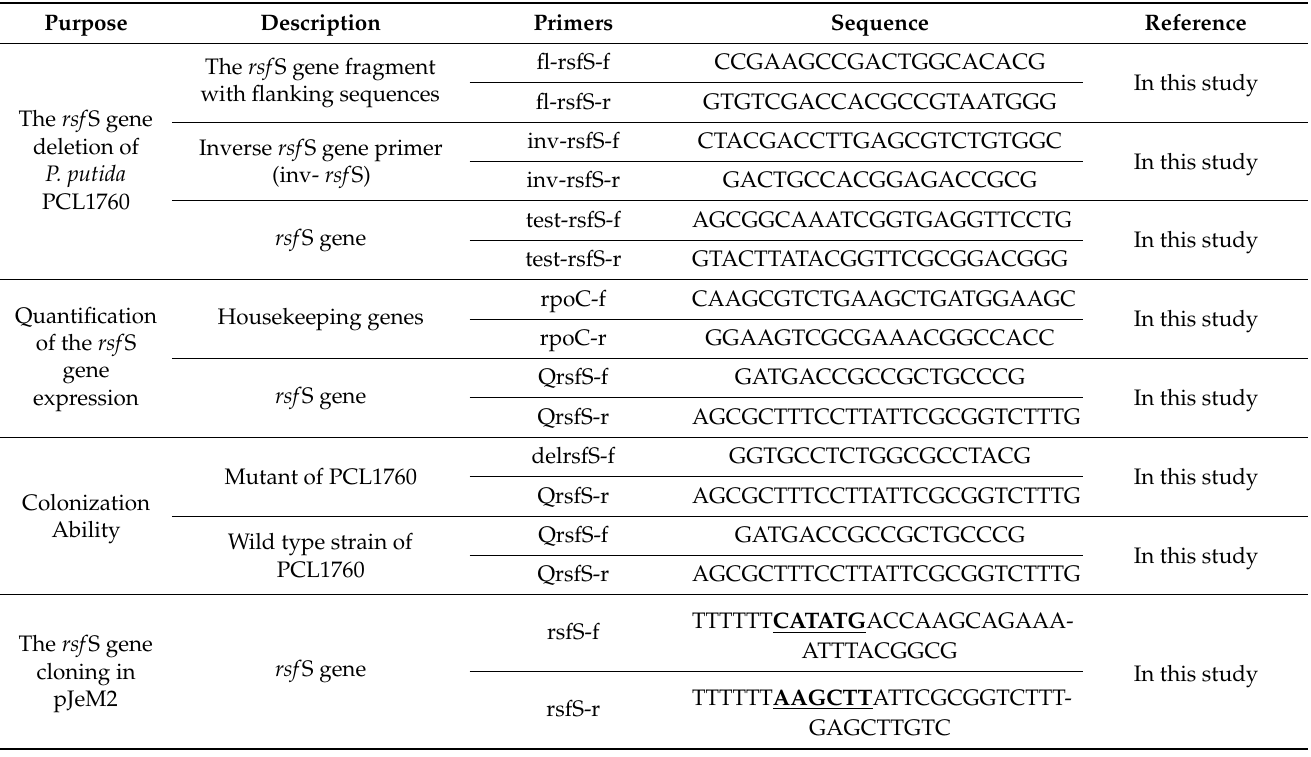
Table 2. Oligonucleotide primers used in this